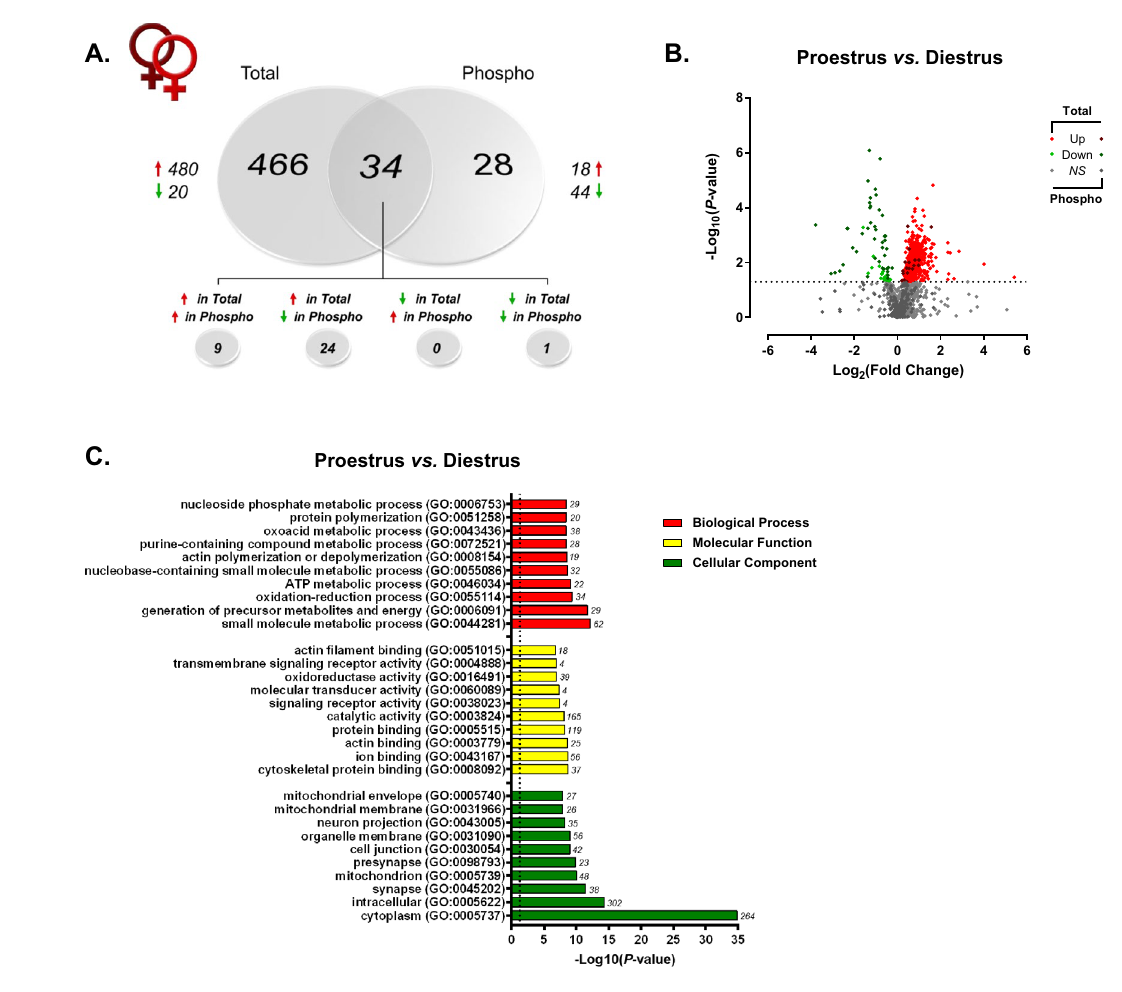
Figure 4. Estrous cycle-dependent total and phosphoprotein expression in the dHPC. ( A ) Venn diagram showing number of total (“Total”) and phosphoproteins (“Phospho”) with significant differential abundance between female rats in either proestrus or diestrus. Red arrows indicate greater levels observed in proestrus vs. diestrus females. ( B ) Volcano plot depicting significant differences in protein and phosphoprotein abundance between proestrus and diestrus female rats. Log 2 (Fold Change) values > 0 (red) indicate higher, and those < 0 (green) lower, abundance in proestrus females compared to diestrus females. Dots above the horizontal dashed line represent proteins with p < 0.05 (FDR threshold set at 1%). ( C ) Top 10 most significant ( p < 0.05) gene ontology (GO) enrichment terms per category of proteins and phosphoproteins with significant estrous cycle- dependent abundance